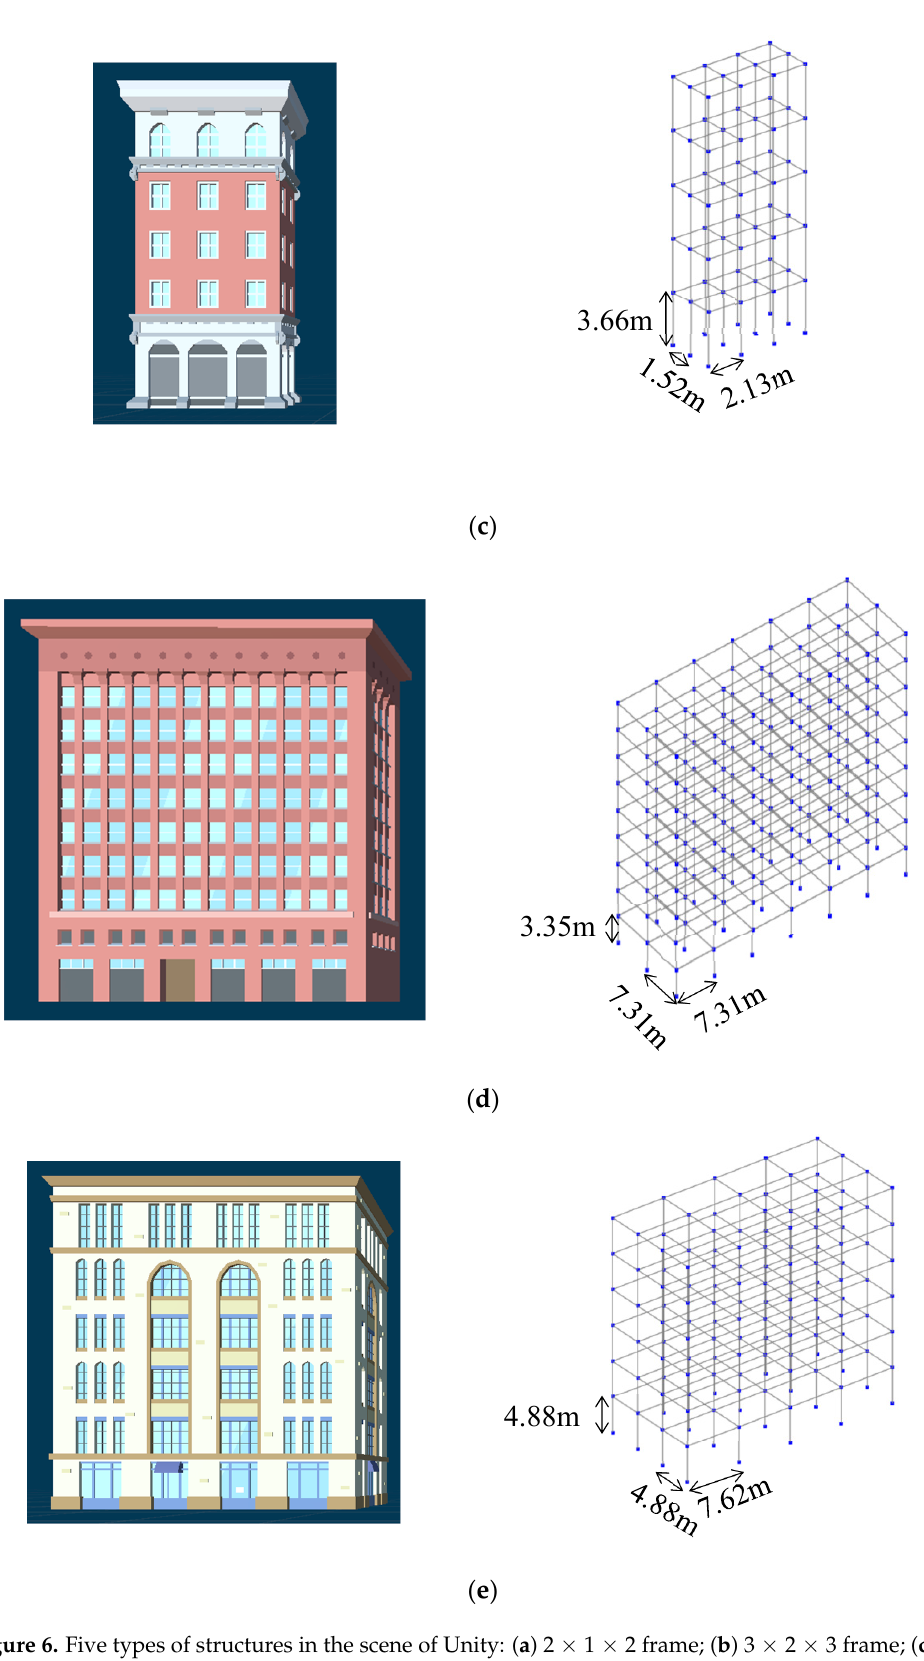
Figure 6. Five types of structures in the scene of Unity: ( a ) 2 × 1 × 2 frame; ( b ) 3 × 2 × 3 frame; ( c ) 3 × 2 × 5 frame; ( d ) 6 × 2 × 9 frame; ( e ) 4 × 3 × 6 frame.